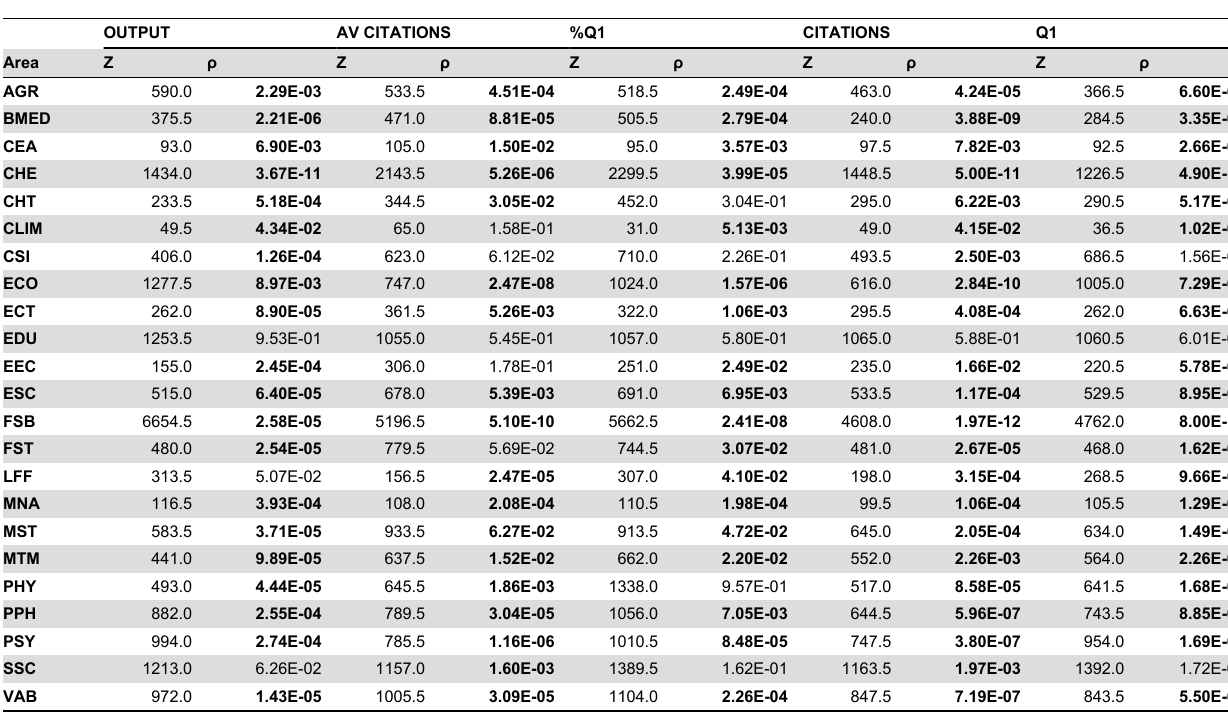
Table 4. Wilcoxon signed-rank test for bibliometric variables (awarded vs. rejected